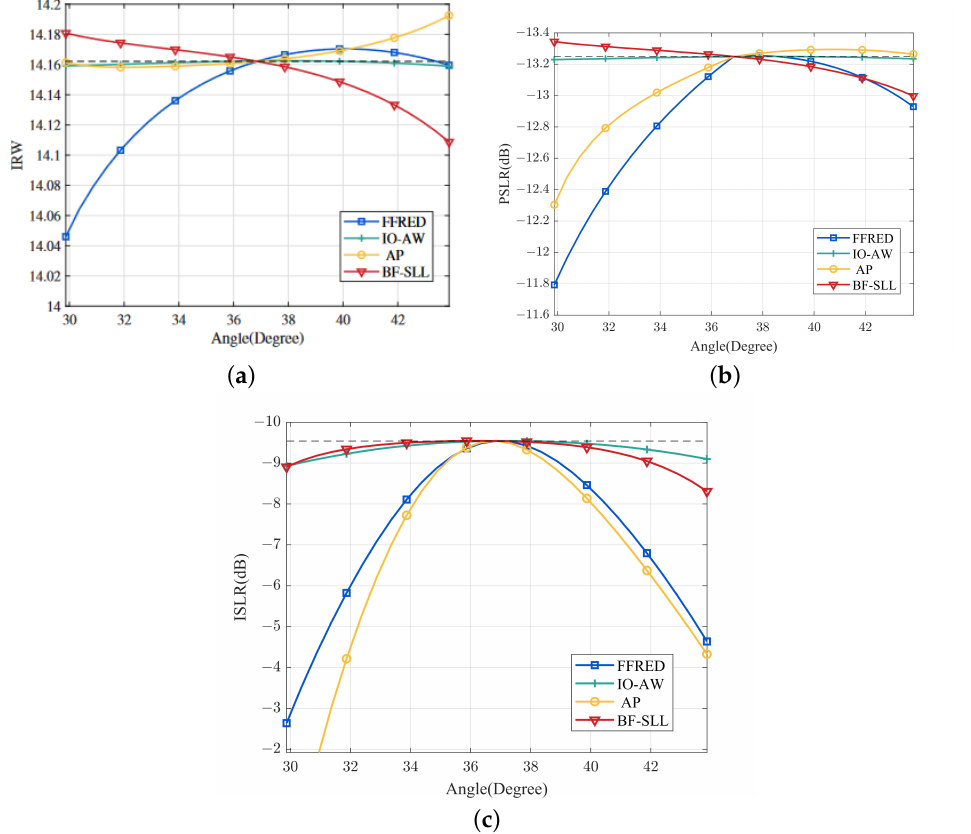
Figure 4. Performance of matched filtering in the radar beam. ( a ) IRW of different methods. ( b ) MF − PSLR of different methods. ( c ) MF − ISLR of different